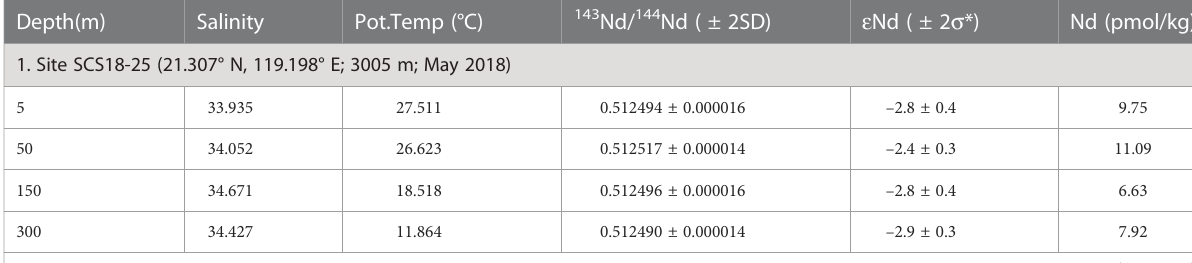
TABLE 1 Location, water depts, salinity, potential temperature, 143 Nd/ 144 Nd ratio, ϵ Nd value and Nd concentration of the seawater samples analyzed in this study. Depth(m) Salinity Pot.Temp